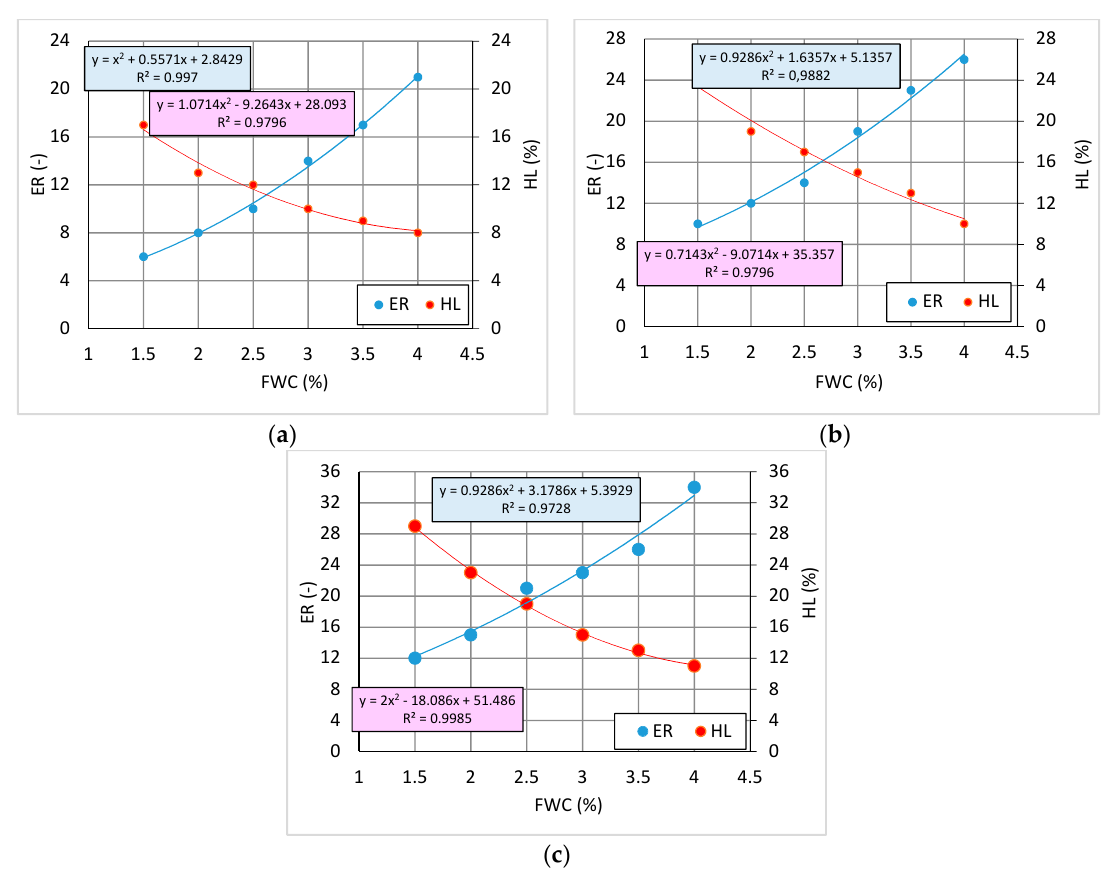
Table 12. Foamed 50/70 bitumen parameters versus binder type and additive content.